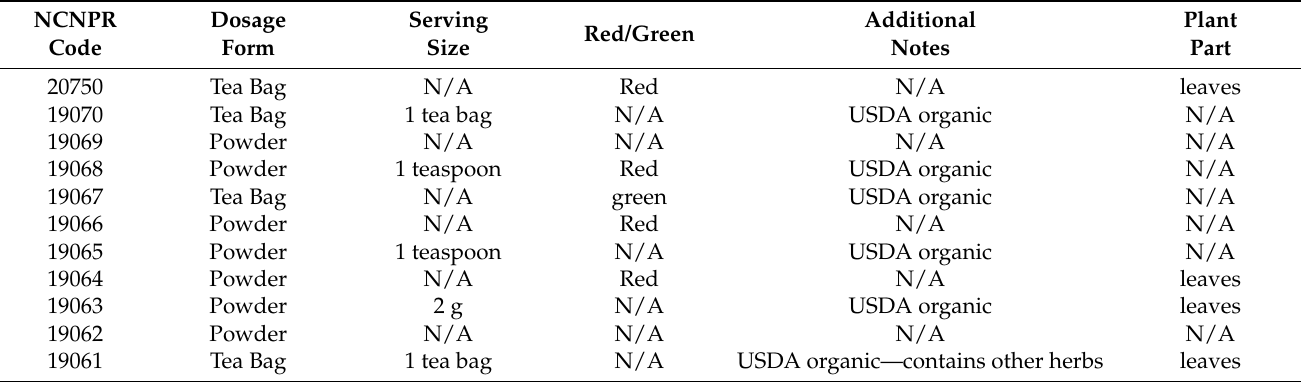
Table 1. NCNPR Code, product name, dosage form, serving size, type of tea, plant part